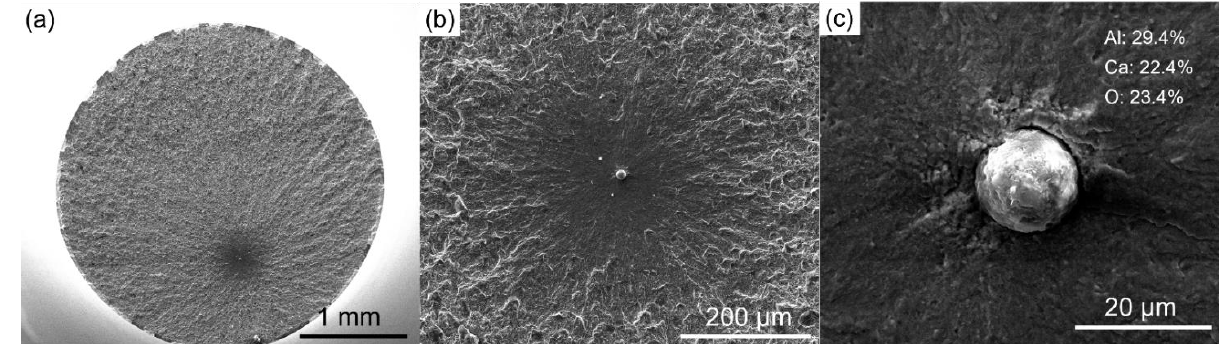
Figure 7. The morphology of the fatigue fracture and the inclusion inducing the fatigue crack (σ = 1200 MPa; N f = 2.97 × 10 8 ): ( a ) fracture surface; ( b ) optically dark area (ODA) structure; ( c ) the inclusion in crack initiation site.